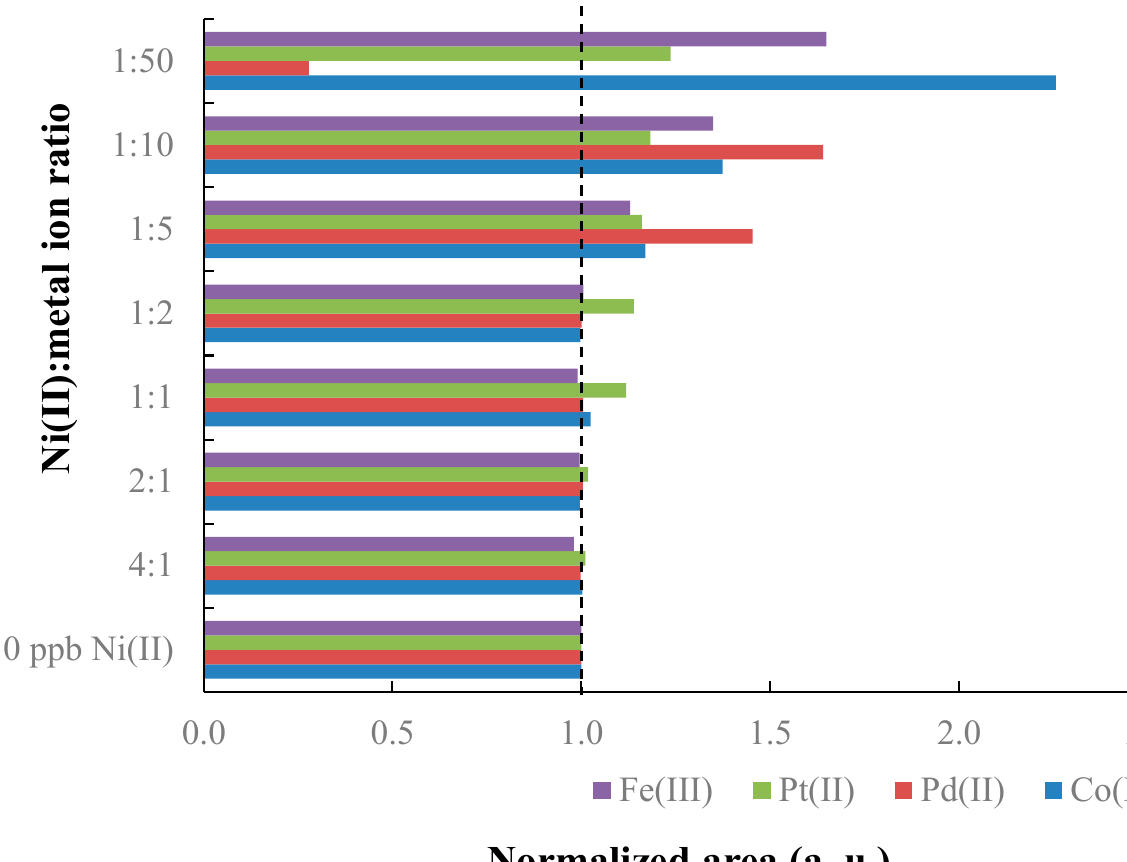
Figure 3. Effect of different Ni(II): metal ion ratios on the Ni(II) peak area. Co(II), Pd(II), Pt(II) and Fe(II) were considered as potential interfering metal ions.